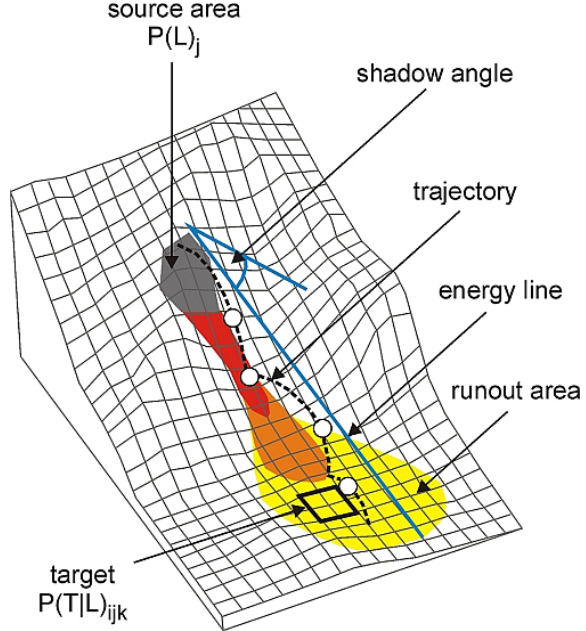
Fig. 2. Definition of rockfall hazard and related parameters (modi- fied, after Jaboyedoff et al., 2001).